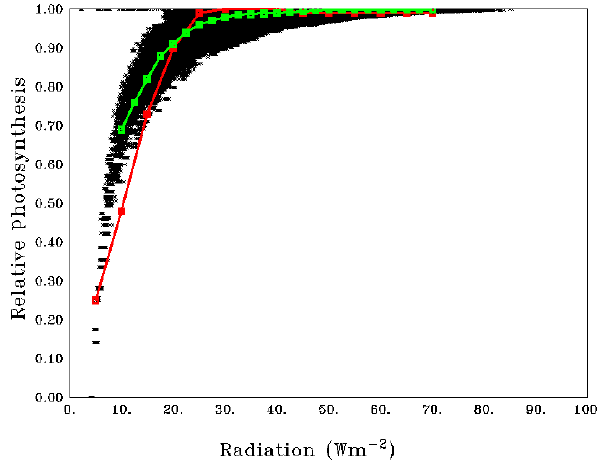
Figure 2. Scatter of average relative photosynthesis versus differ- ent light intensities in the model (black dots) and its mean (green curve). The red curve shows the theoretical P–I curve from Parsons et al.